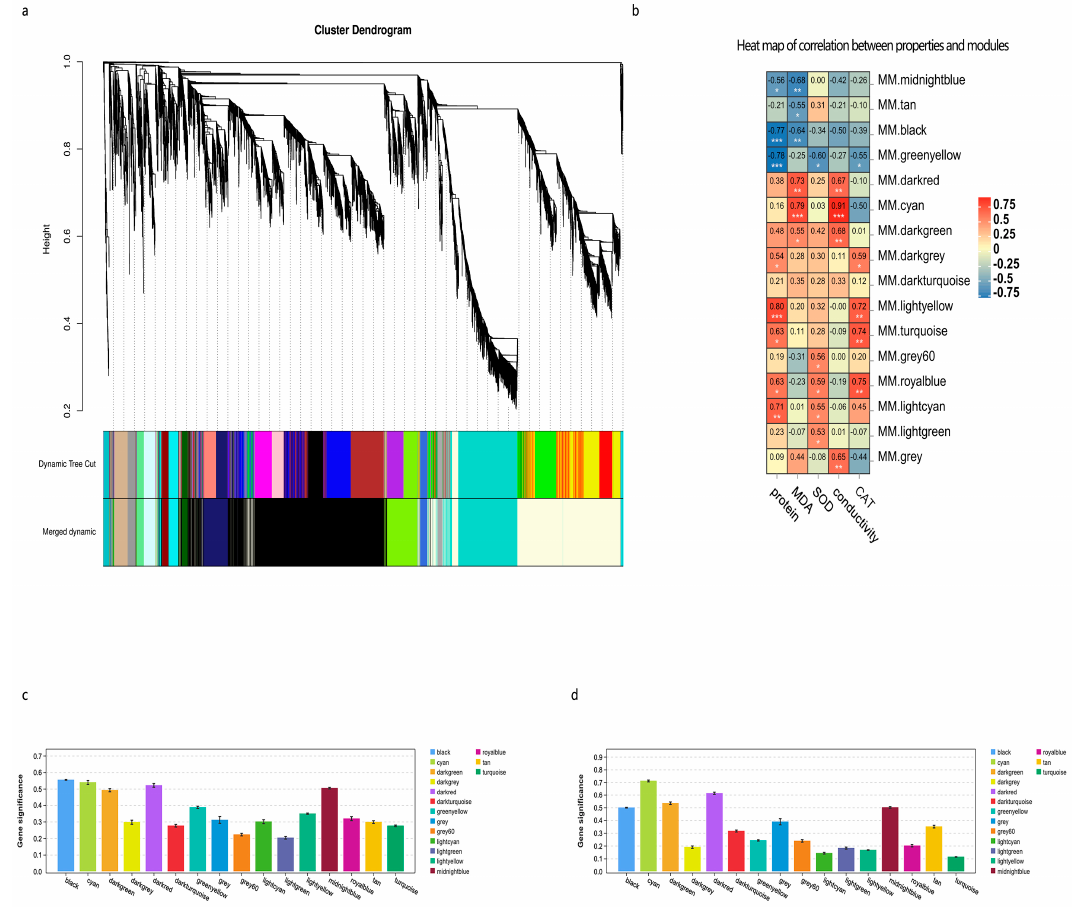
Figure 9. Weighted gene co-expression network analysis (WGCNA) and module–trait correlation analysis results. ( a ) Hierarchical clustering tree showing co-expression modules identified using the dynamic tree-cutting method. Different modules are indicated by different colors. Each leaf in the tree represents a gene. The main branches formed 16 modules, indicated by different colors. ( b ) biochemistry indicators and WGCNA modules. Each row corresponds to a module shown in ( a ). The columns correspond to biochemistry indices, and the color of each cell indicates the difference between the correlation coefficient module and the biochemistry index. Numbers in the cells indi- cate correlation coefficients; asterisks indicate statistical significance. ( c ) Correlations between soluble proteins and WGCNA modules. ( d ) Correlation between MDA content and WGCNA modules. The number of genes in each module ranged from 30 to 2469; the gray module con- tained 30 genes that were not assigned to other modules. Correlation analysis of module